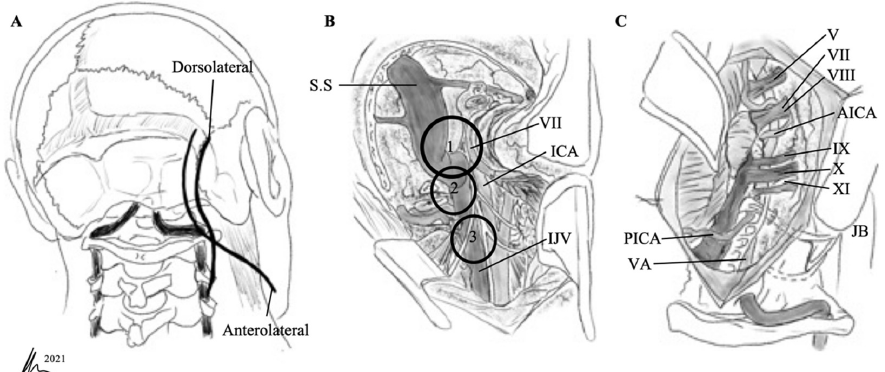
Figure 2. ( A ) For the dorsolateral approach, a lazy S or bigger C incision is used, about 1 cm posterior to the mastoid bone, extending inferiorly along the hairline. For the anterolateral ELITE procedure, a retroauricular curvilinear C-shaped, or question-mark-shaped, skin incision is begun approximately 2 to 3 cm posterior to the upper border of the ear. Inferiorly, this incision is carried down into the neck, traversing the border of the sternocleidomastoid muscle and running parallel to the body of the mandible (fingerbreadths below). For the dorsolateral approach, the sternocleidomastoid muscle is retracted anteriorly; for the anterolateral approach, it is retracted posteriorly. ( B ) Exposure by different techniques: (1) suprajugular, infralabyrinthine; (2) infrajugular, transcondylar; and (3) high cervical. SS, sigmoid sinus; ICA, internal carotid artery; IJV, internal jugular vein. ( C ) Anterolateral techniques with high cervical dissection. AICA, anterior inferior cerebellar artery; PICA, posterior inferior cerebellar artery; VA, vertebral artery; JB, jugular